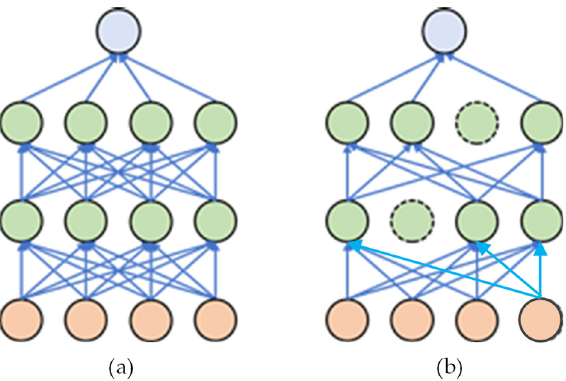
Figure 3. Example of dropout: ( a ) standard feedforward network; ( b ) two hidden units are discon- nected.